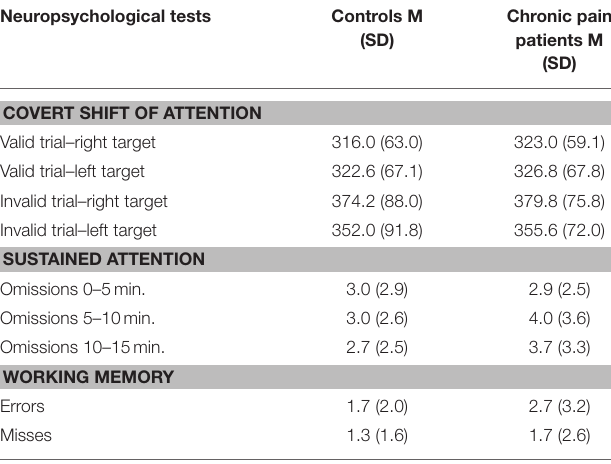
TABLE 4 | Descriptive results from the subtests of the computerized TAP battery for chronic pain patients and controls